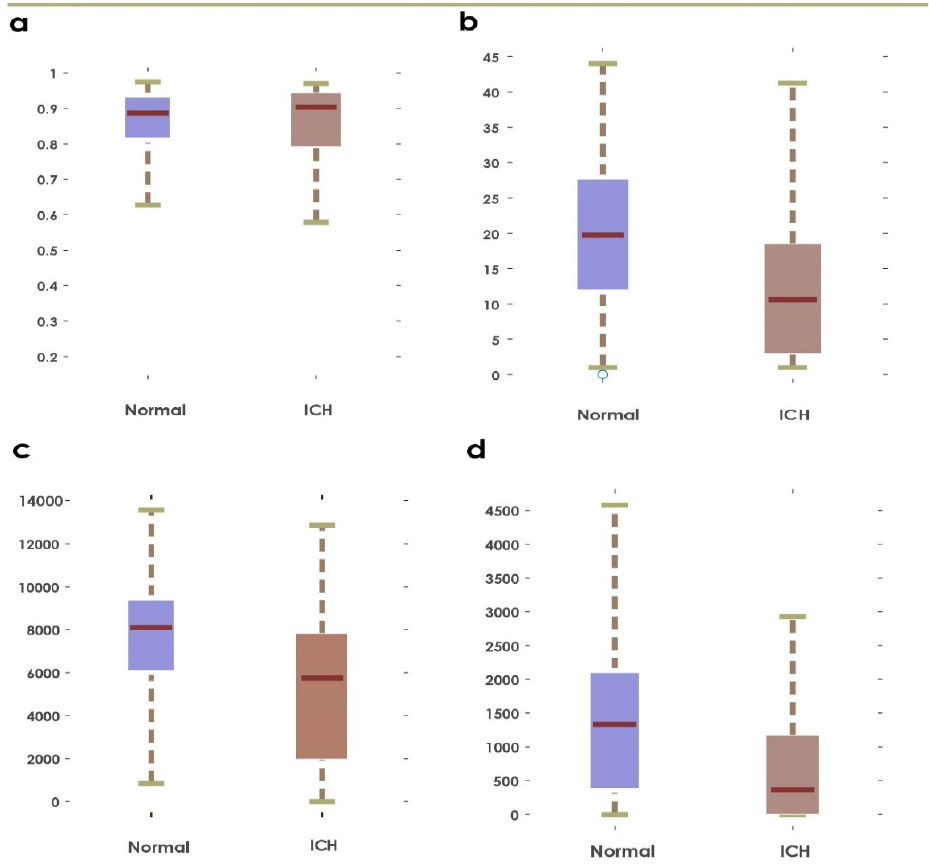
Figure 4. Boxplots obtained using first ranked feature before and after applying Grey Wolf Optimi- zation: ( a , b ): GLCM and Hu’s invariant moments, ( c , d ): GLRLM and statistical features.